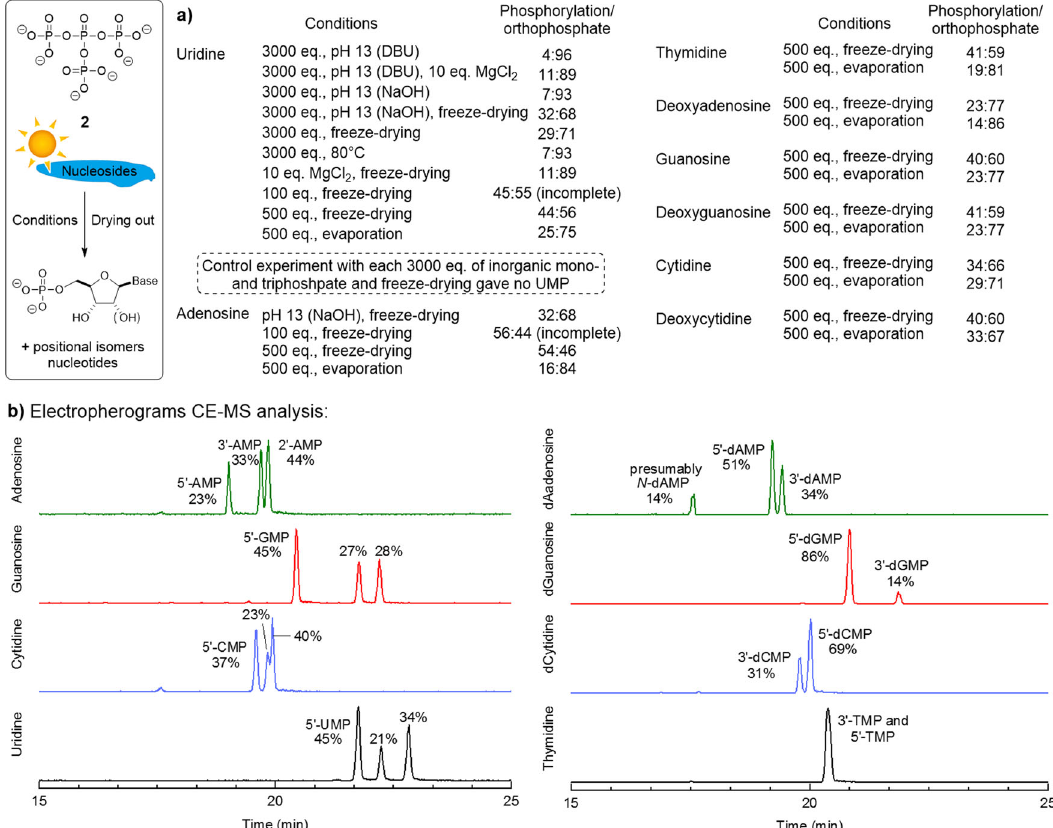
Fig. 6 Phosphorylation of nucleosides by uP 4 (2) and electropherograms of the CE-MS analysis. a Conditions and phosphorylation rates for the reaction of nucleosides with uP 4 . If the pH of the nucleophile solution was adjusted, the applied base is indicated in brackets. Phosphorylation rates were calculated without consideration of the phosphoramidate by-product arising from the reaction of DBU with uP 4 . b Electropherograms of the CE-MS analysis of the product distribution. The positional isomers were determined by spiking